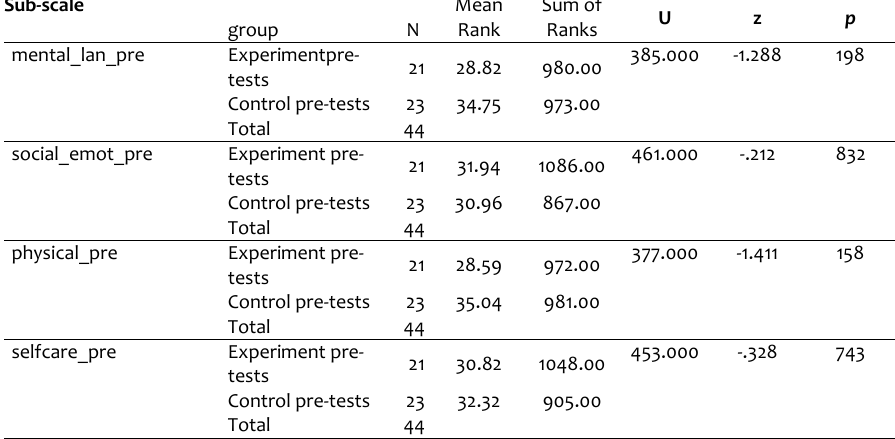
Table 2. Pre-test results of the development scores in experimental and control groups